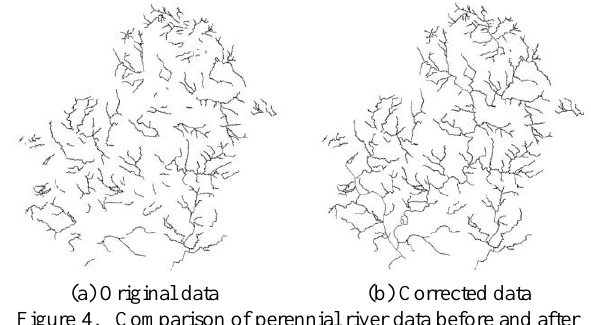
Figure 4. Comparison of perennial river data before and after the automatic attribute